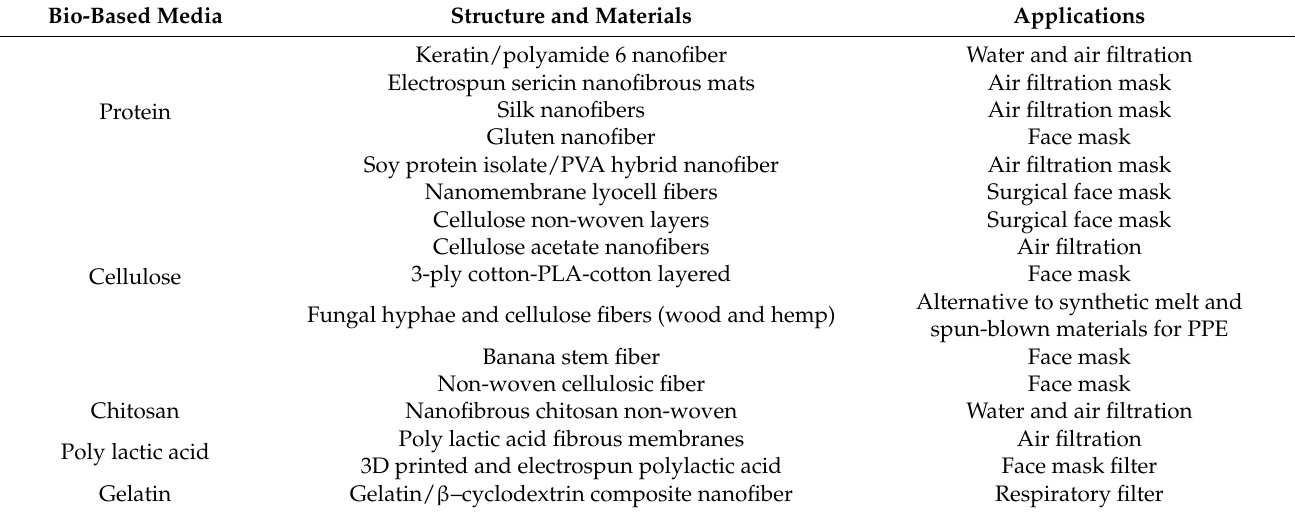
Table 6. Bio-based materials for the surgical face mask